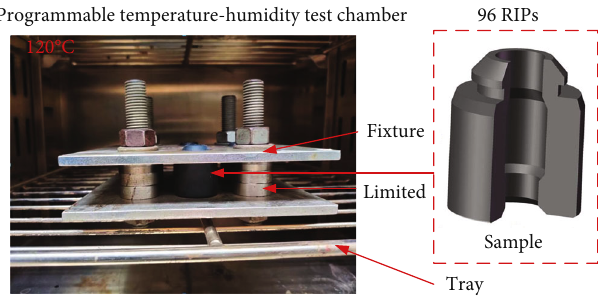
Figure 7: Thermal oxygen aging experiment graph of the RIPs at the temperature of 120 ° C.